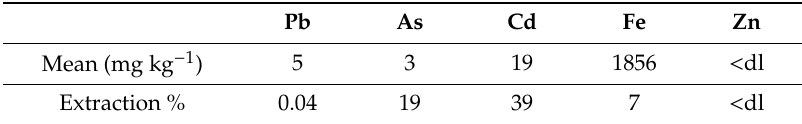
Table 4. Mean potentially toxic element (PTE) content and extraction percentage after the selective extraction. Pb As Cd Fe Zn Mean (mg kg − 1 ) 5 3 19 1856 < dl Extraction % 0.04 19 39 7 < dl < dl: below the detection